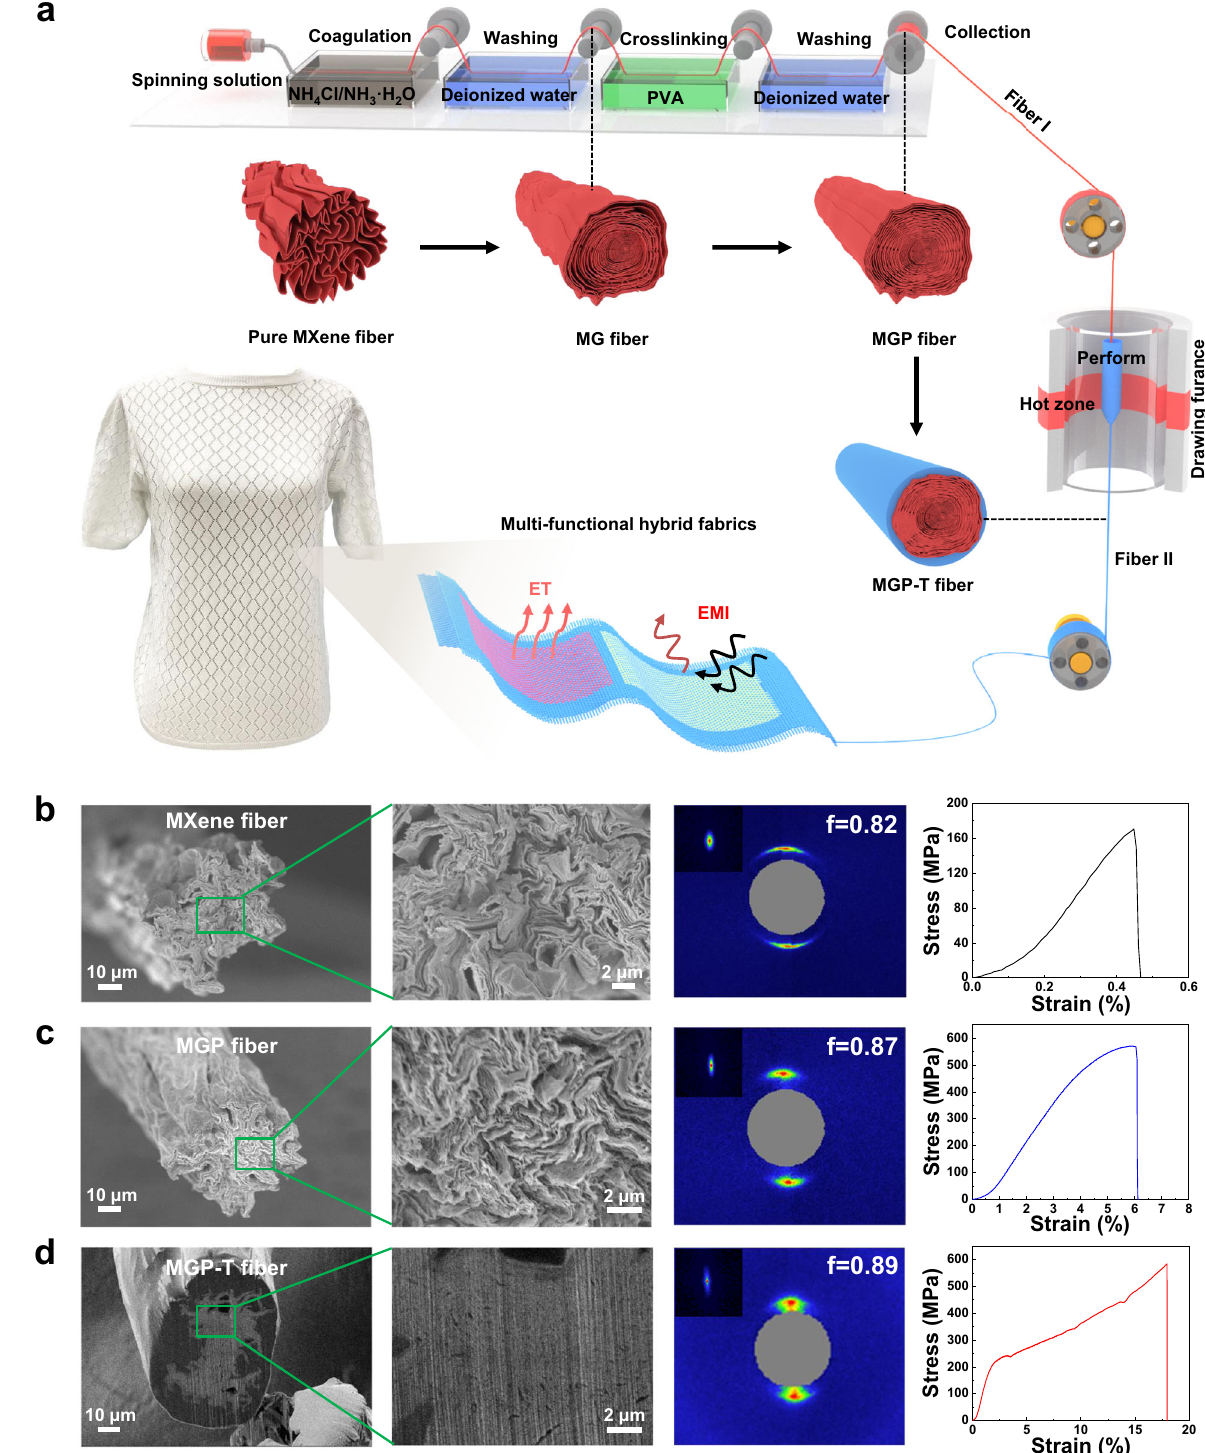
Fig. 1 | Fabrication fl ow toachieveultra-compact MXene fi bers.a Fabrication of MGP-T fi berviacontinuouswetspinningandthermaldrawing,andtheformationof MXene-based textiles. SEM cross-sections of MXene fi bers with the WAXS/SAXS patternsandstress-straincurves: b PureMXene fi bers; c MGP fi bersafterinterfacial